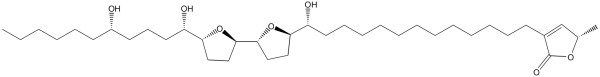
Structure of squamocin. Squamocin is characterized by a long alkyl chain bearing a terminal α, β-unsaturated γ-lactone ring, two tetrahydrofuran rings, and some oxygenated substitutes along the chain.